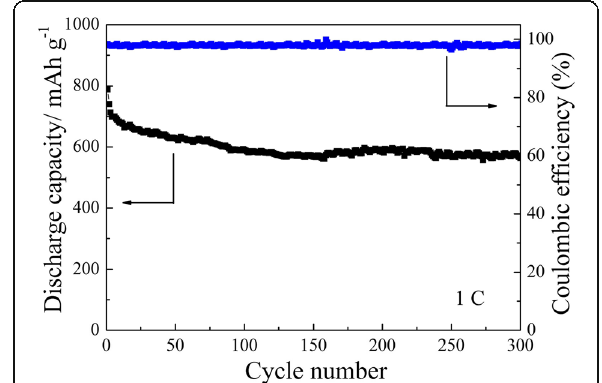
Fig. 8 The charge/discharge curves of the cell with TiO 2 /PC- modified Celgard 2400 separator at 0.1 C